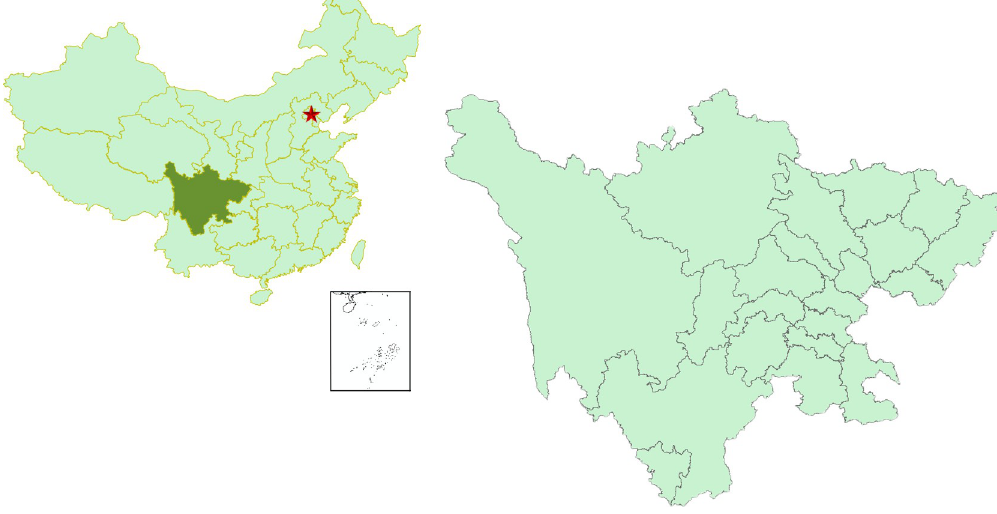
Fig 1. Map of Sichuan. � The source of shape files was a public database, National Nature Resources and Geospatial basic information database of PRC (http://www.geodata.gov.cn/web/geo/index.html). Those shape files were under license without need for